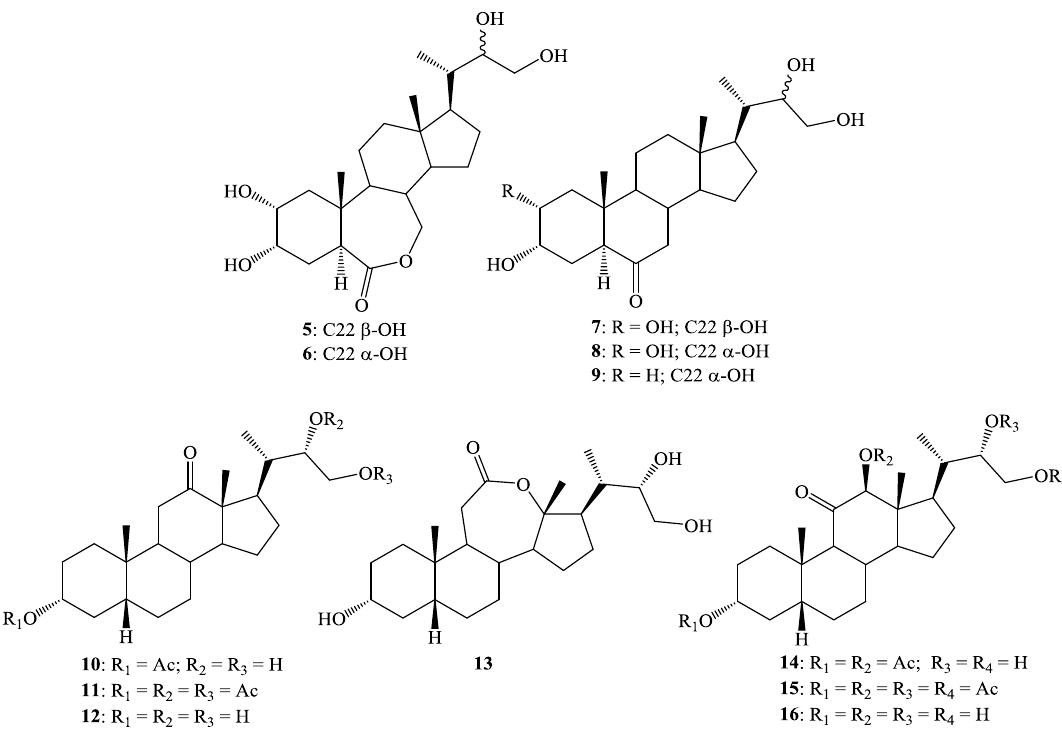
Figure 2. Synthetic 24-nor-22( S ),23-dihydroxy analogs 5 – 16 .